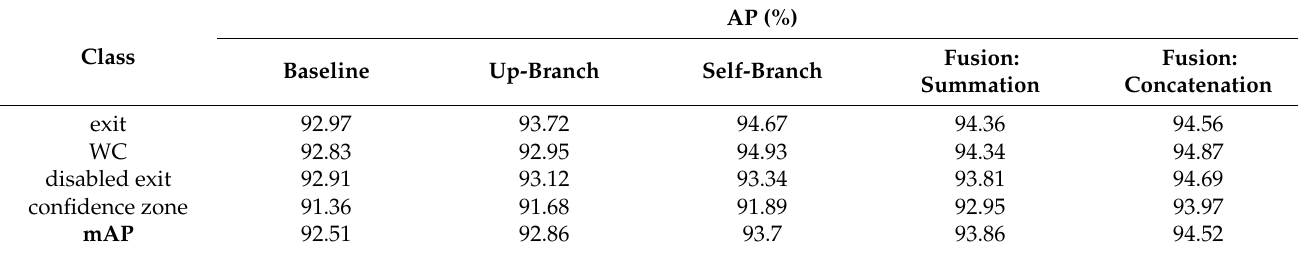
Table 2. Achieved detection rate using the indoor sign detection dataset.